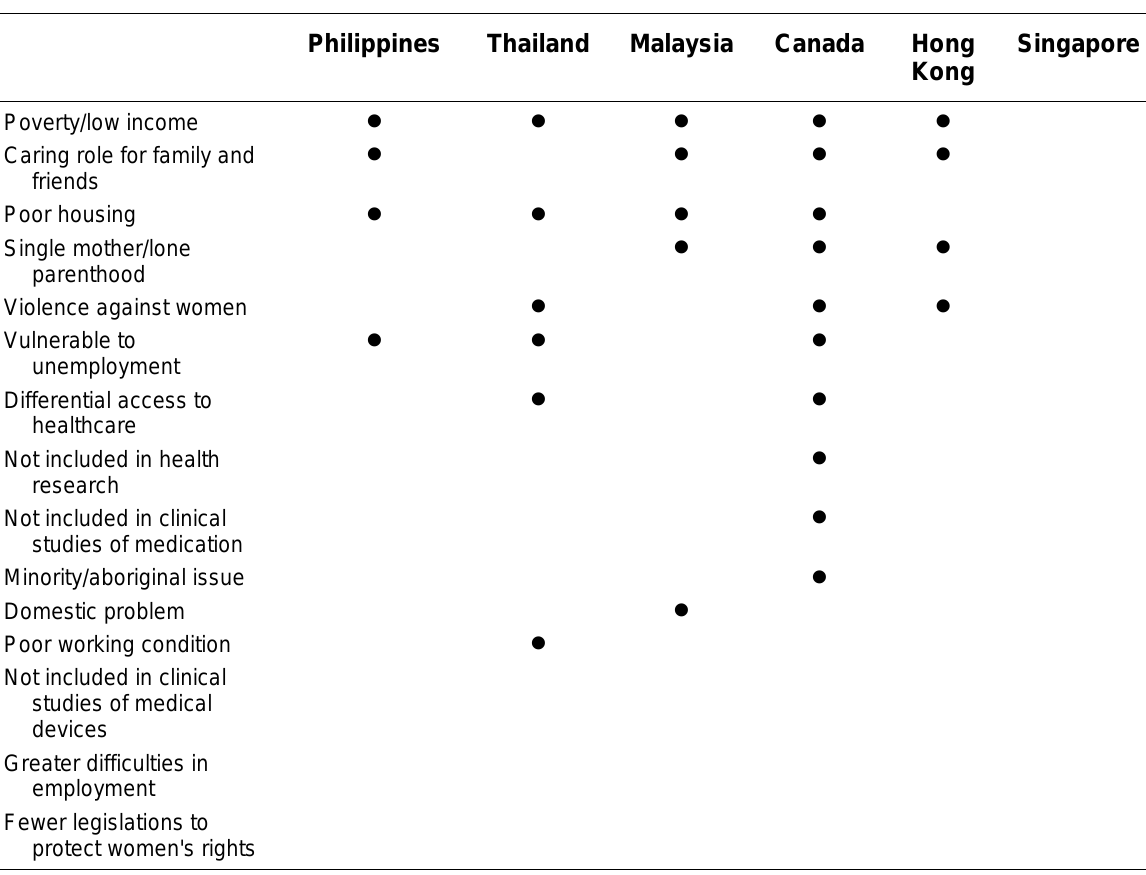
Opinion on Important Social Determinants (Social and Economic) Affecting Women's Health, According to Key Informants During Interview, by